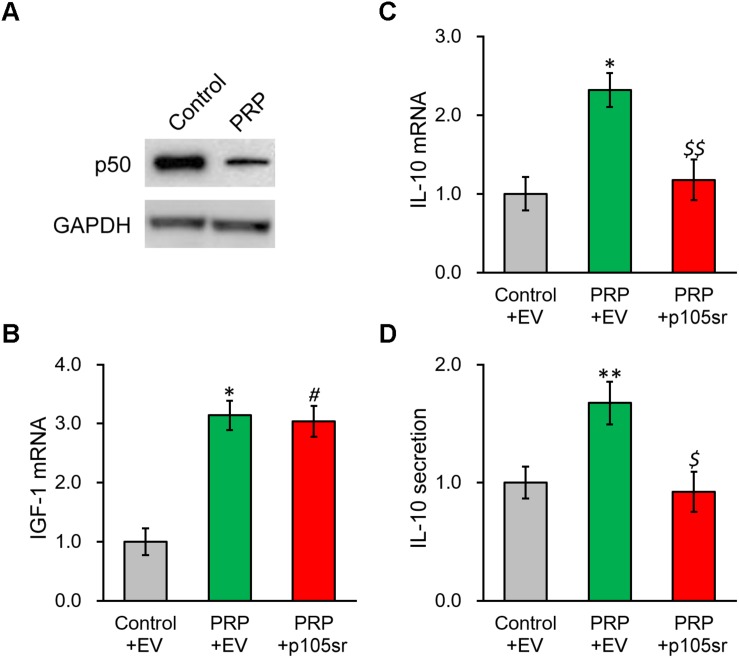
Inhibition of NF-κB p50 subunit abolishes PRP-induced expression and secretion of IL-10 in BMSCs. (A) p50 protein level was examined in control BMSCs and BMSCs treated with PRP. (B) IGF-1 mRNA, (C) IL-10 mRNA and (D) IL-10 secretion in media were examined in control BMSCs transfected with empty vector (control + EV), BMSCs treated with PRP and transfected with empty vector (PRP + EV), and BMSCs treated with PRP and transfected with p50 inhibitor p105sr (PRP + p105sr). Values are mean ±SD at least three independent biological repeats in triplicates. ∗∗P < 0.01, ∗P < 0.05, vs. control + EV. #P < 0.05 vs. control + EV and not significant vs. PRP + EV. $, $$ not significant vs. control + EV and P < 0.05, 0.01, respectively, vs. PRP + EV.